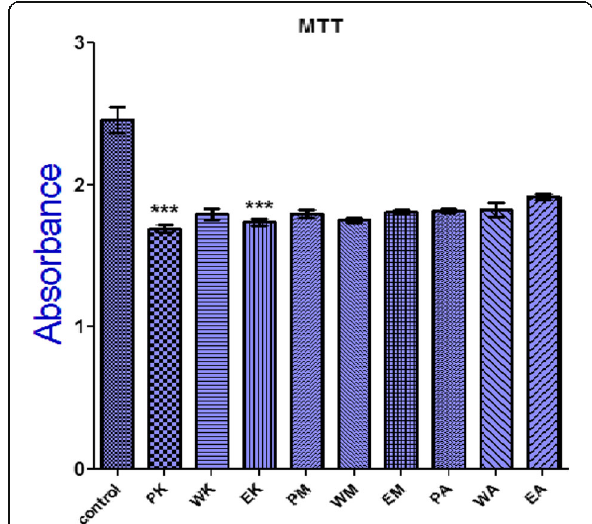
Fig. 5 Anti-proliferative activity of plant extract against HeLa cell line Note: PM (Petroleum ether miswak ), EM (Ethanol Miswak ), WM (Water Miswak ), PK (Petroleum ether Kalonji) , EK (Ethanol Kalonji ), WK (Water Kalonji ), PA (Petroleum ether Aloe vera ), EA (Ethanol Aloe vera ), WA (Water Aloe Vera). Absorbance was taken at 570 nm